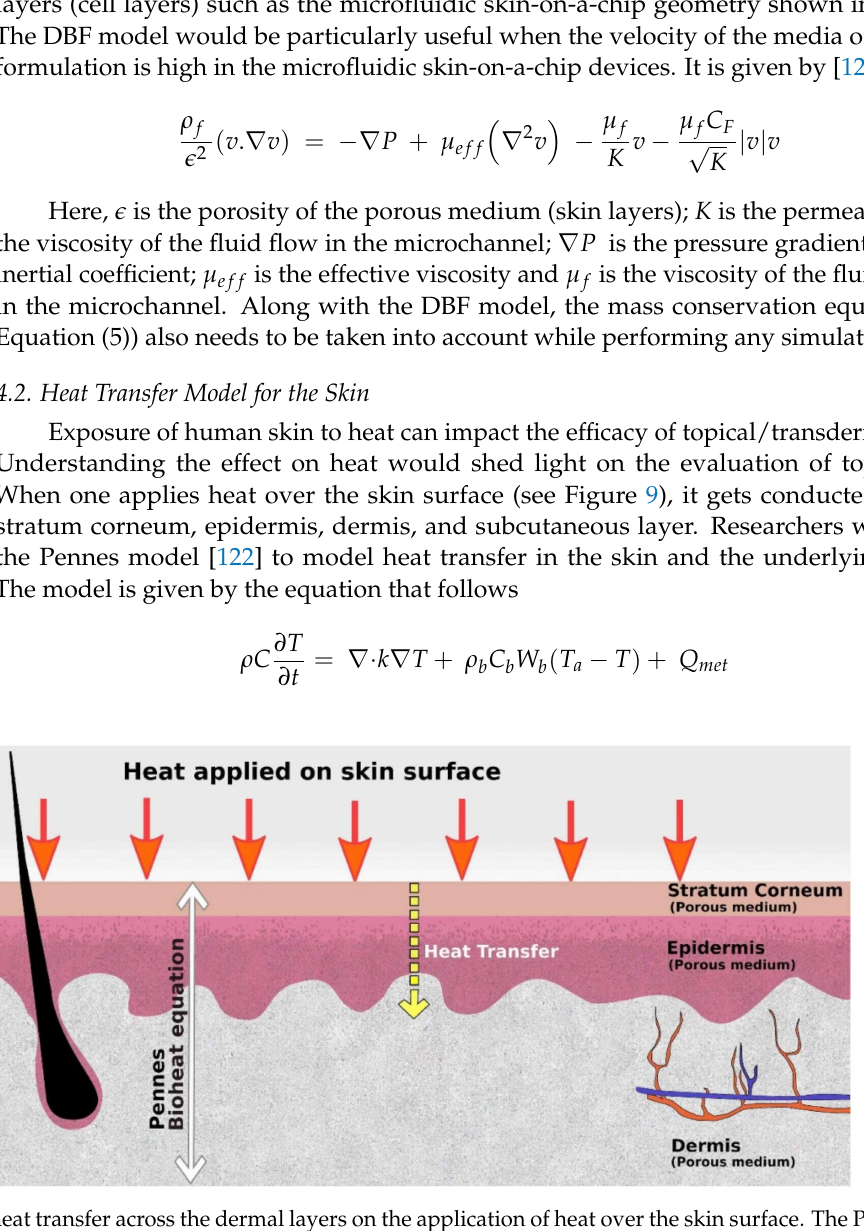
Figure 9. Representation of heat transfer across the dermal layers on the application of heat over the skin surface. The Pennes Bioheat transfer model is a basic model that represents the heat transfer in the